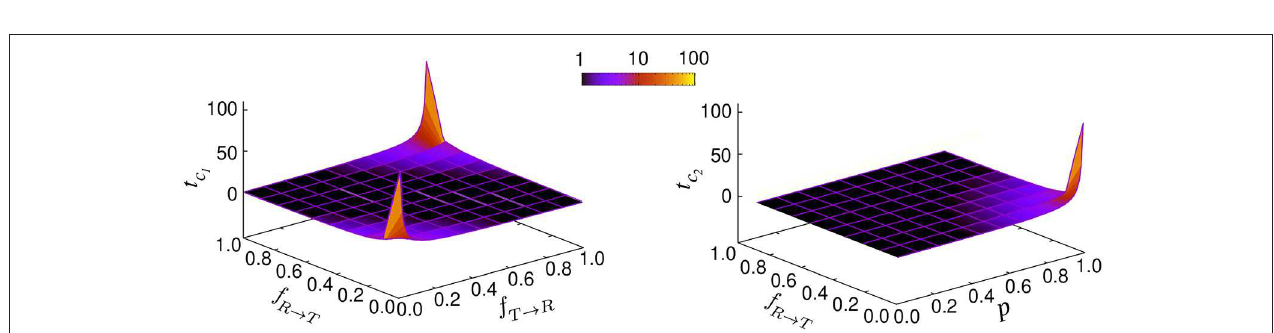
FIGURE 3 | Characteristic times t c 1 and t c 2 in terms of the transition probabilities f